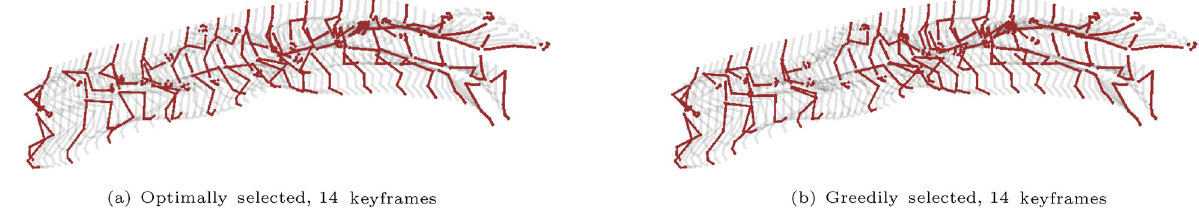
Fig. 9 Another time-lapse example. The keyframes are temporally distributed more consistently in the optimal case (a), with respect to the amount of change between successive frames, than in greedy case (b). The difference can be seen most clearly by focusing on the head of the character and examining the number of inbetweens (non-keyframes, gray) between each pair of keyframes